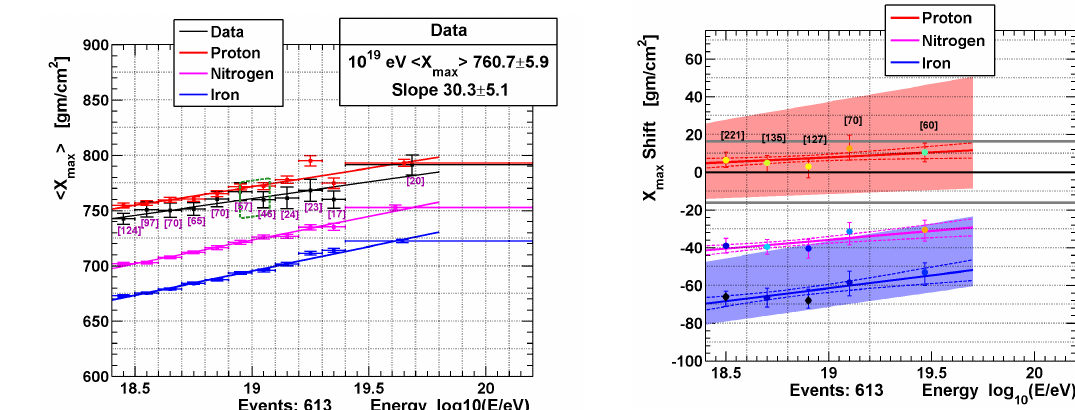
and 4 km, respectively). Middle Drum also uses smaller mirrors. These di ff erences reduce the acceptance of Mid- dle Drum compared to Black Rock Mesa and Long Ridge, and the data analysis for the two data sets are carried out